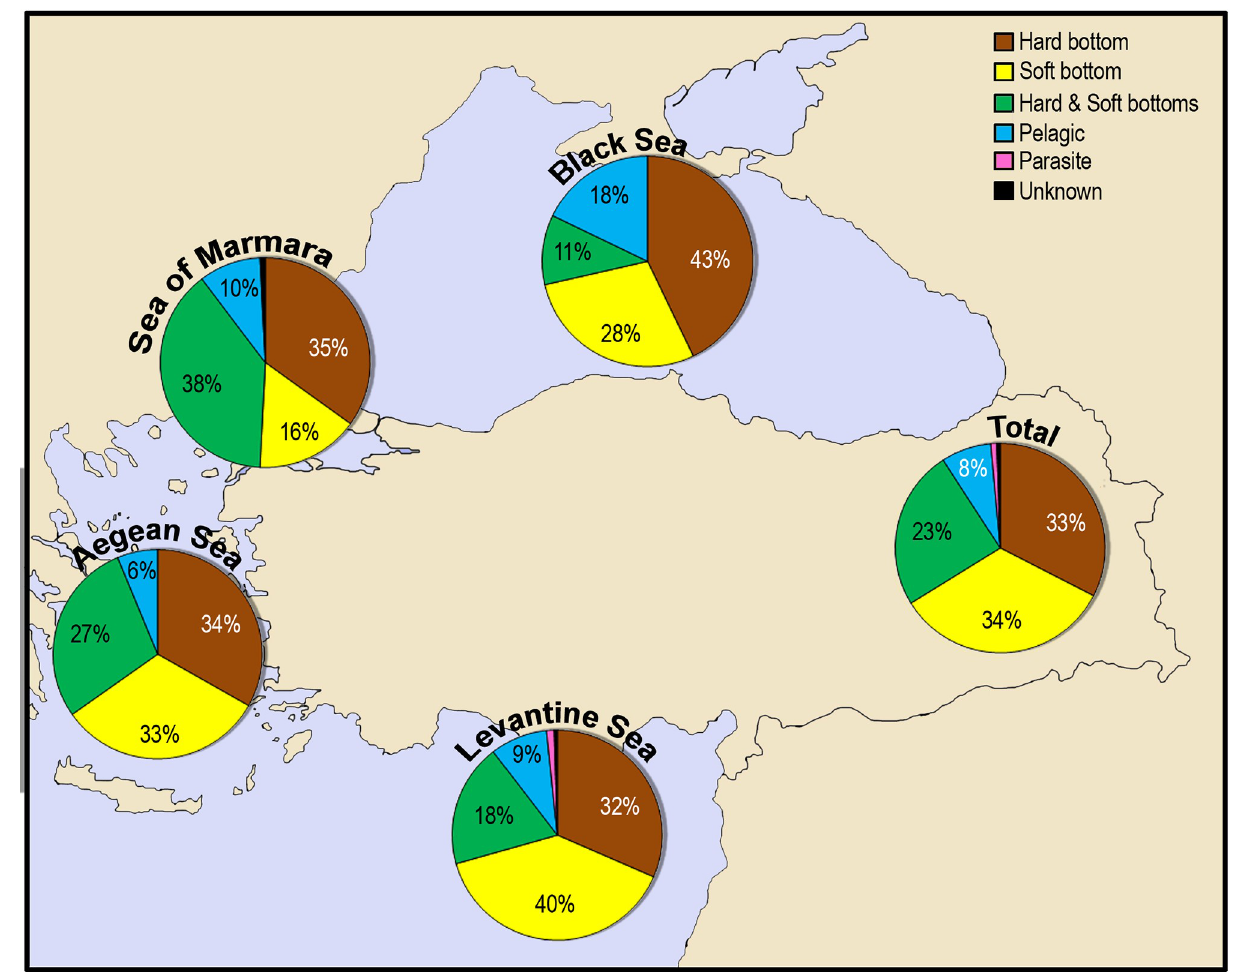
Fig 12. The habitats preferences of alien species on the coasts of